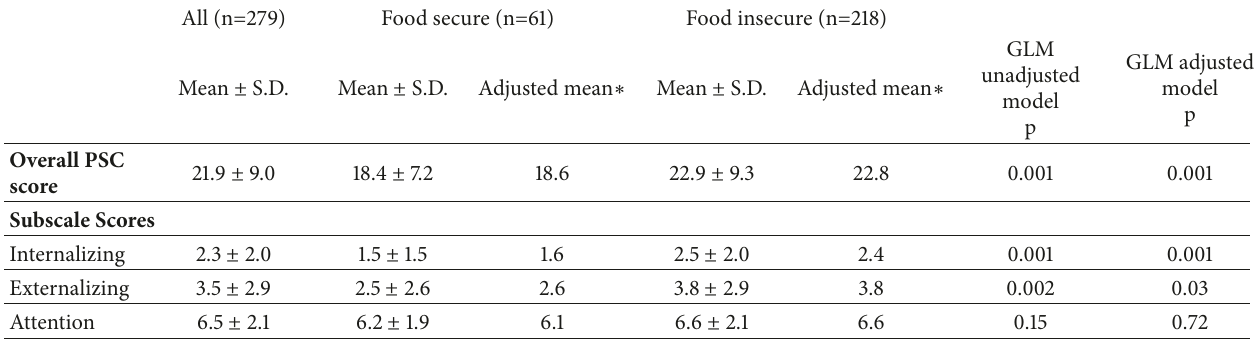
GLM GLM adjusted unadjusted model model p p